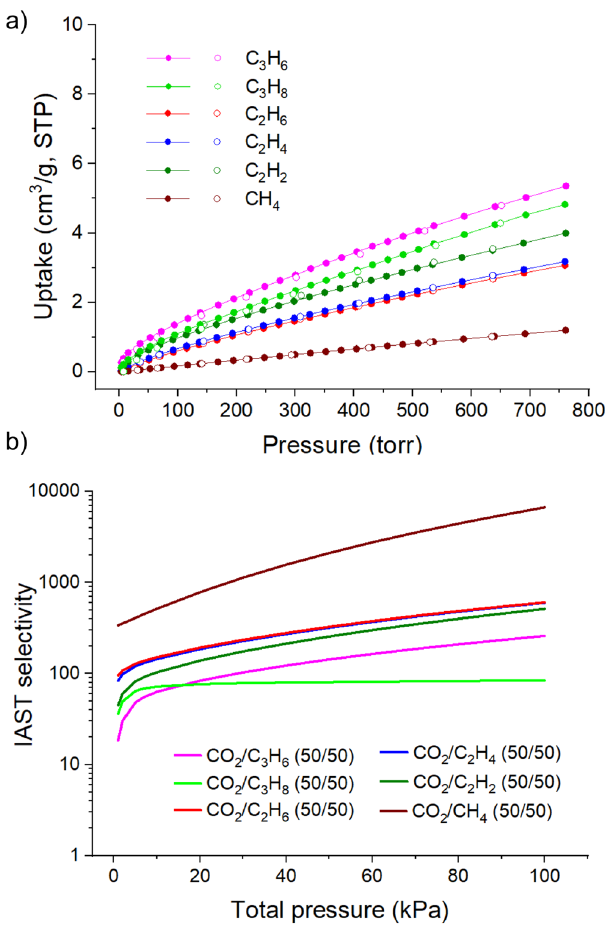
Fig. 4 Gas uptake and calculated separation by MUF-16. a Experimental CH 4 , C 2 H 2 , C 2 H 4 , C 2 H 6 , C 3 H 6 and C 3 H 8 adsorption (solid spheres) and desorption (open spheres) isotherms of MUF-16 measured at 293 K. b Predicted IAST selectivities, displayed with a log scale, of MUF-16 for various gas mixtures at 293 K. Source data are provided as a Source Data fi le.